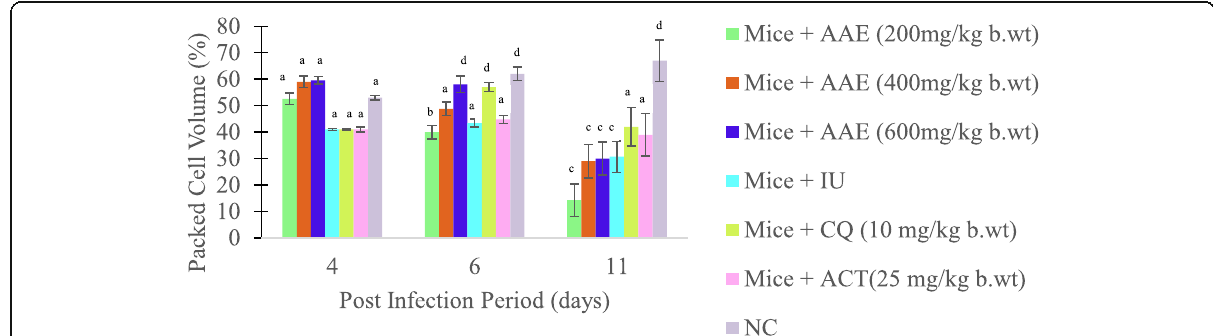
Fig. 3 Effect of aqueous extract of A. aspera on the PCV level of mice infected with P. berghei (NK-65). Mice + AAE = infected mice treated with Achyranthes aspera aqueous extract, mice + IU = infected mice untreated, mice + CQ = infected mice treated with chloroquine (10 mg/kg), mice + ACT = infected mice treated with artemisinin (25 mg/kg) and NC = normal control group. Values with different superscript are significantly different at p <